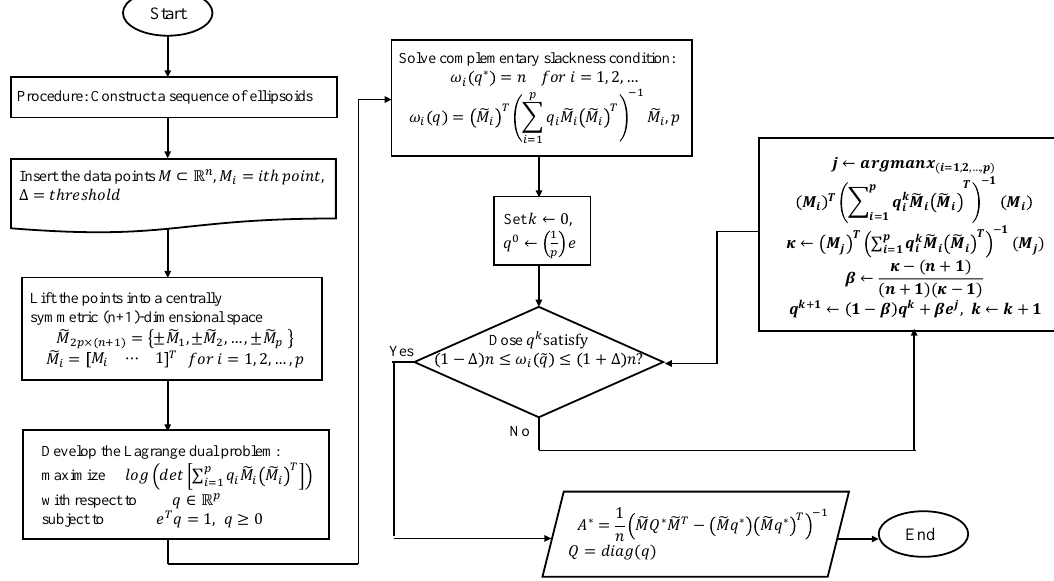
Figure 4. Iterative method to solve the problem of finding minimum volume enclosing ellipsoid